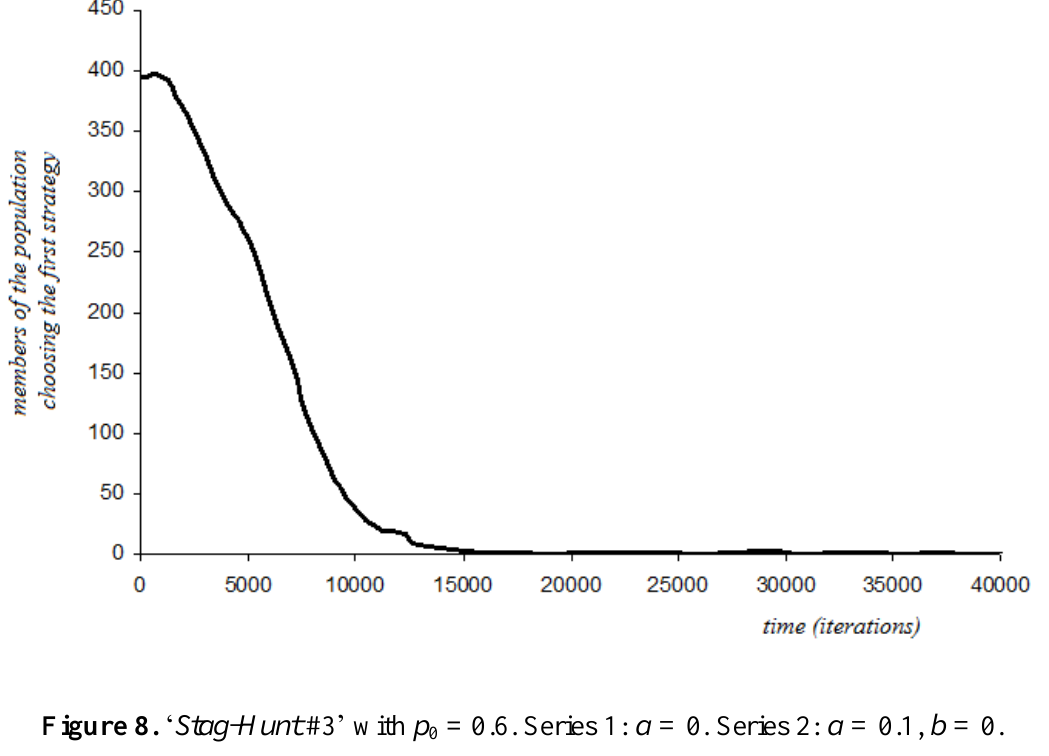
Figure 8. ‘ Stag-Hunt #3’ with p